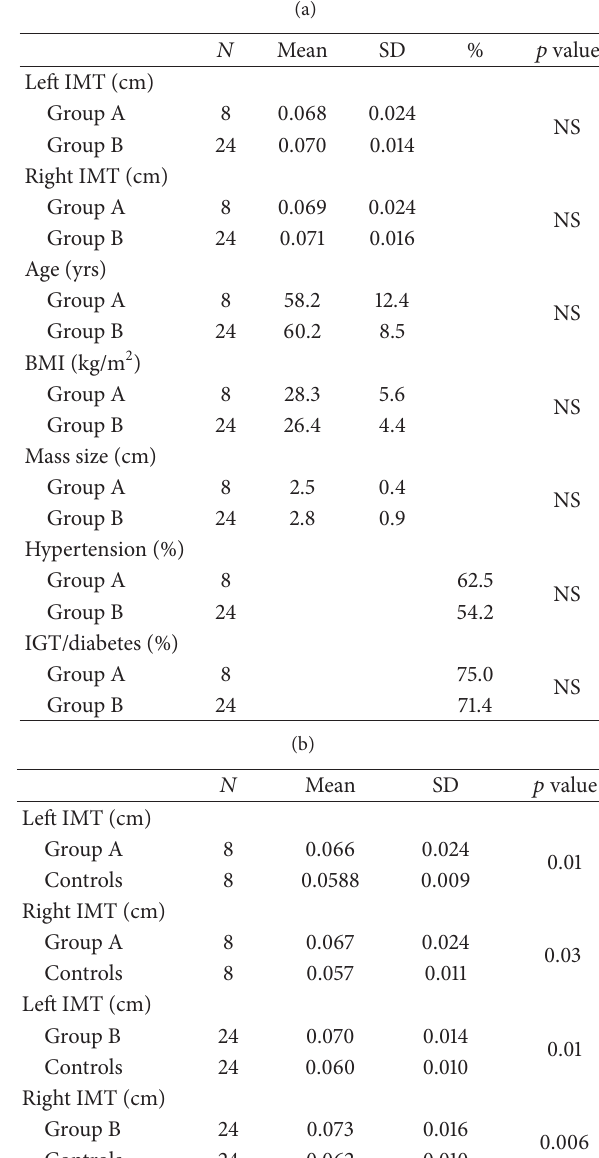
Table 2: Comparison of IMT values between SCS and nonsecreting AI with the matched controls (a). Comparison of clinical parameters between patients with SCS and nonsecreting AI (b).